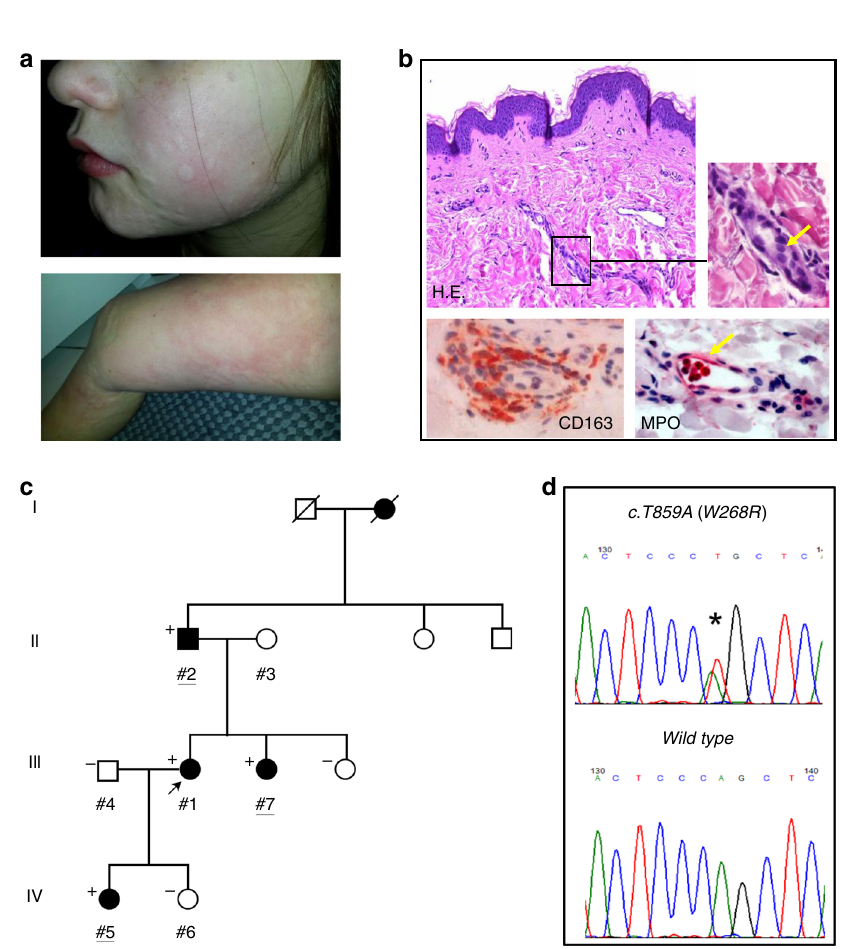
Fig. 1 Phenotype and genotype in patients with FXII-associated cold autoin fl ammatory syndrome (FACAS). a Urticarial rash of the face of a 9-year-old girl and the leg of her 35-year-old mother. b Skin histopathology reveals dermal edema (H.E. yellow arrow) and perivascular in fi ltrates composed of macrophages (CD163) and few intravascular neutrophils (myeloperoxidase [MPO], yellow arrow). Original magni fi cation ×400 ( n = 2 technical replicates). c Family pedigree over four generations identifying affected (shaded black) and unaffected (unshaded) individuals. Exome sequenced individuals are underlined. Where conducted, the results of Sanger sequencing of p.W286R are shown to top left of each individual whereby “ + ” denotes heterozygote for variant and wild-type, and “ − ” denotes healthy reference. d Representative sequencing chromatogram of the heterozygous genotype in an affected individual (top) and chromatogram of healthy individual from the same region